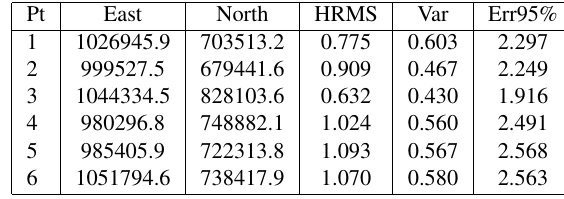
Table 10: Kriging Ordinary Prediction in the municipality cen- troids